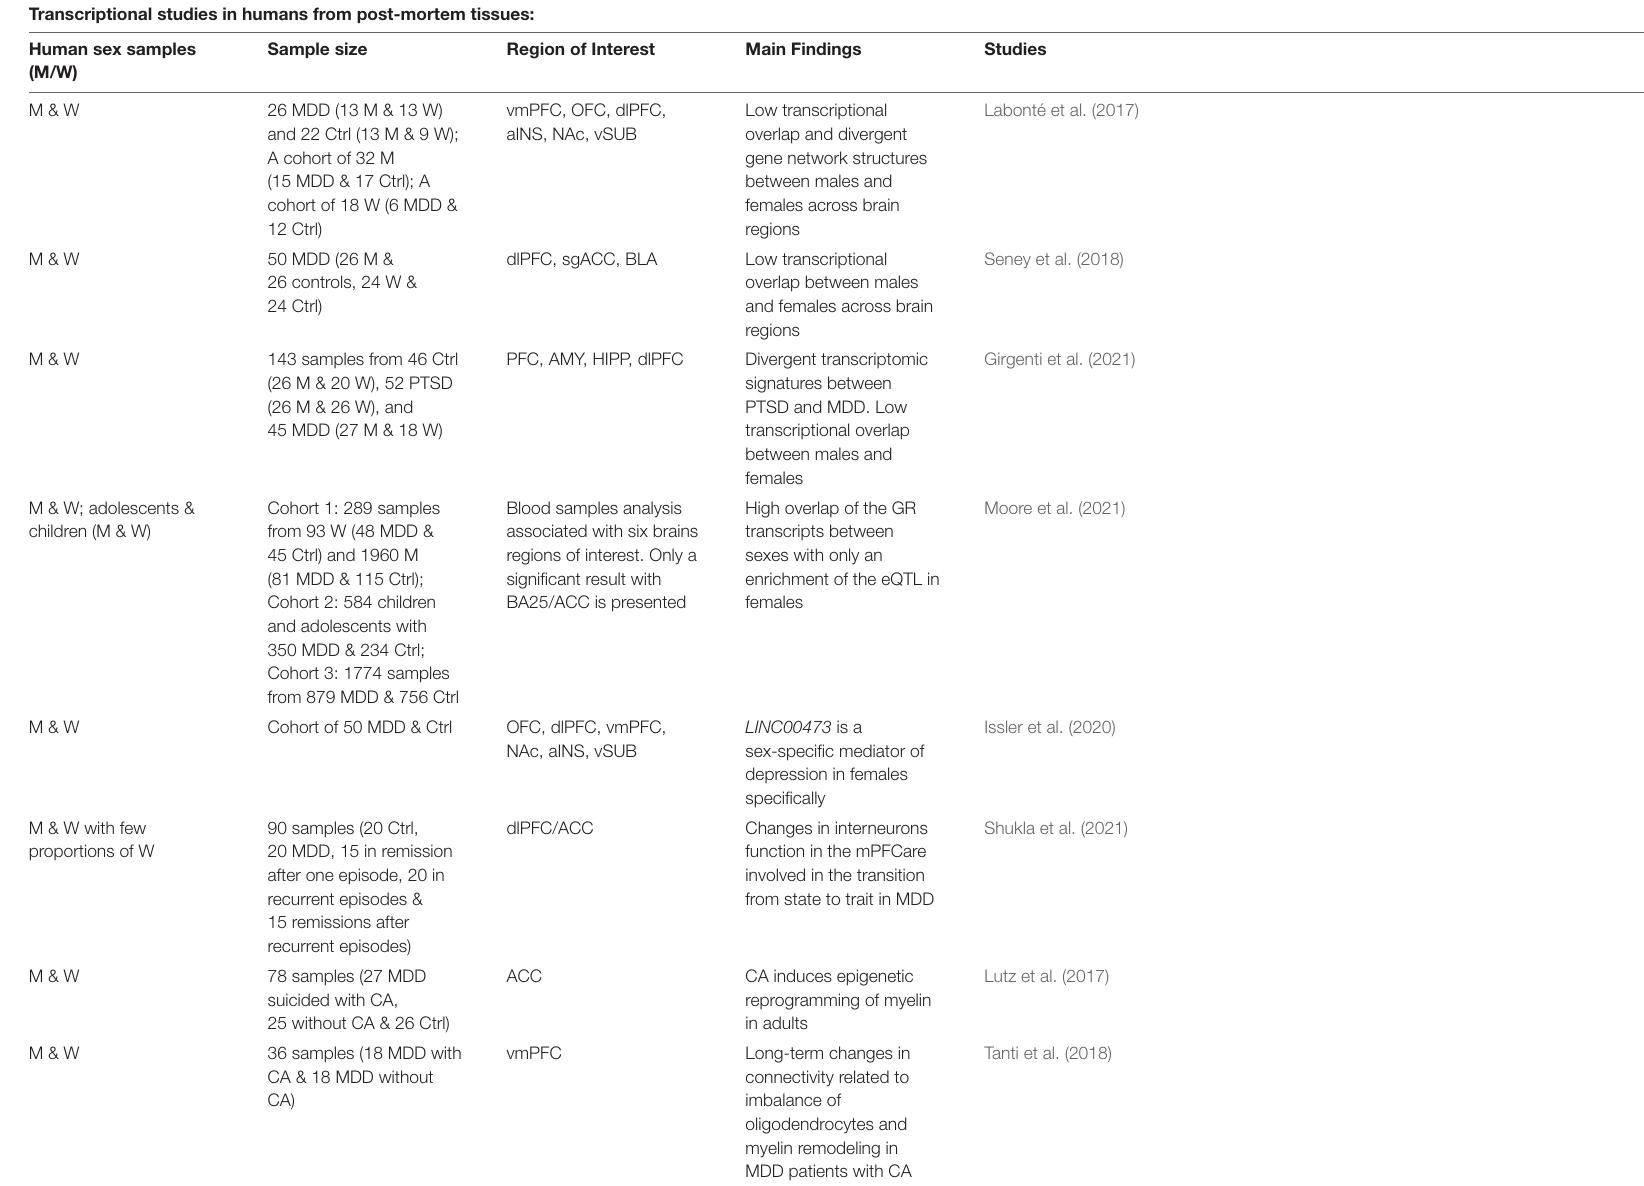
TABLE 1 | Summary of recent transcriptomic analyses done by RNA-sequencing characterizing transcriptional profiles in human MDD post-mortem brains and different animal models of depressive-like behaviors. Transcriptional studies in humans from post-mortem